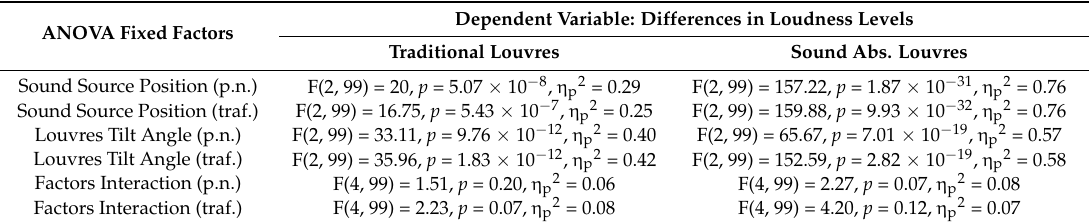
Table A1. Two-way Factorial ANOVAs results referred to the differences in Loudness.